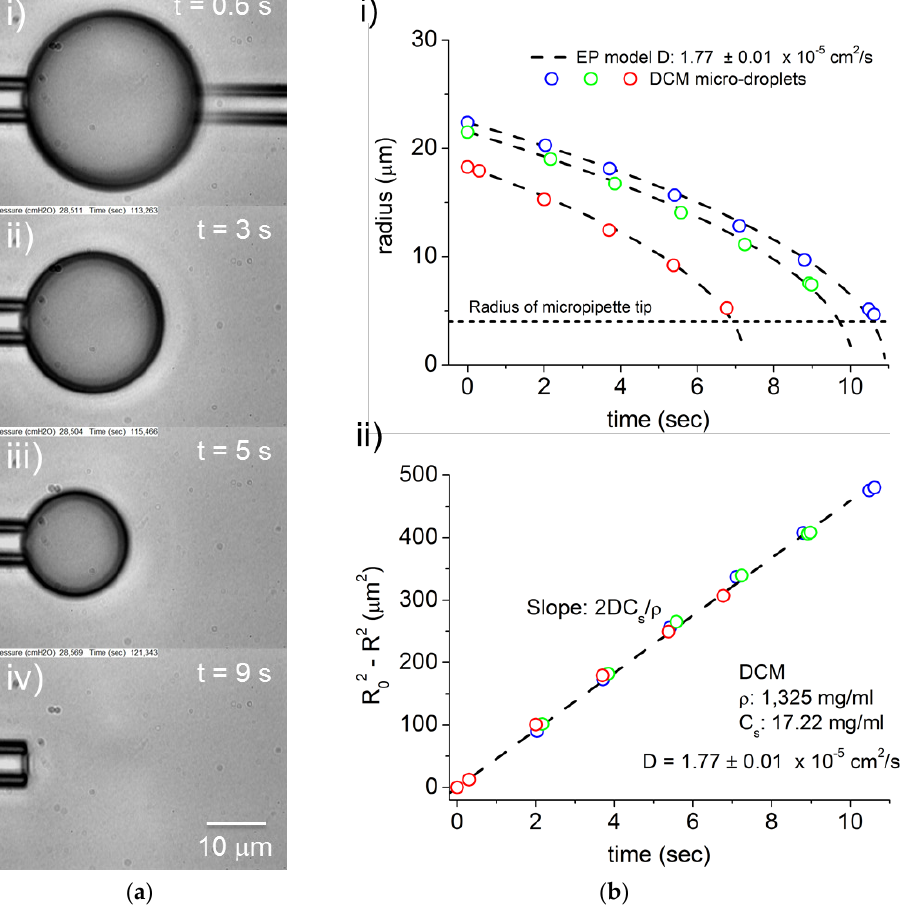
Figure 6. Solvent microdroplet dissolution. ( a ) Video micrographs of a microdroplet formation and dissolution: (i) a microdroplet was formed with the delivery pipette ( t = 0.6 s); (ii) the isolated microdroplet lost dichloromethane (DCM) over time ( t = 3 s); (iii) the isolated microdroplet lost DCM over time ( t = 5 s); (iv) the isolated microdroplet reached the size of the holding pipette ( t = 9 s) and was aspirated inside of the micropipette. ( b ) Graphs representing microdroplet dissolution: (i) droplet radius vs. time for three separate microdroplets of DCM dissolving in water. Extrapolation of the data (green open circles) for the droplet shown in video micrographs (i)–(iv) to radius = 0, shows that the droplet was entirely dissolved in ~10 s. Dotted line is the radius of the micropipette tip and so when droplet reaches this size it was aspirated up the pipette; (ii) R 02 – R 2 vs. time plot that collapsed the data onto a single line.